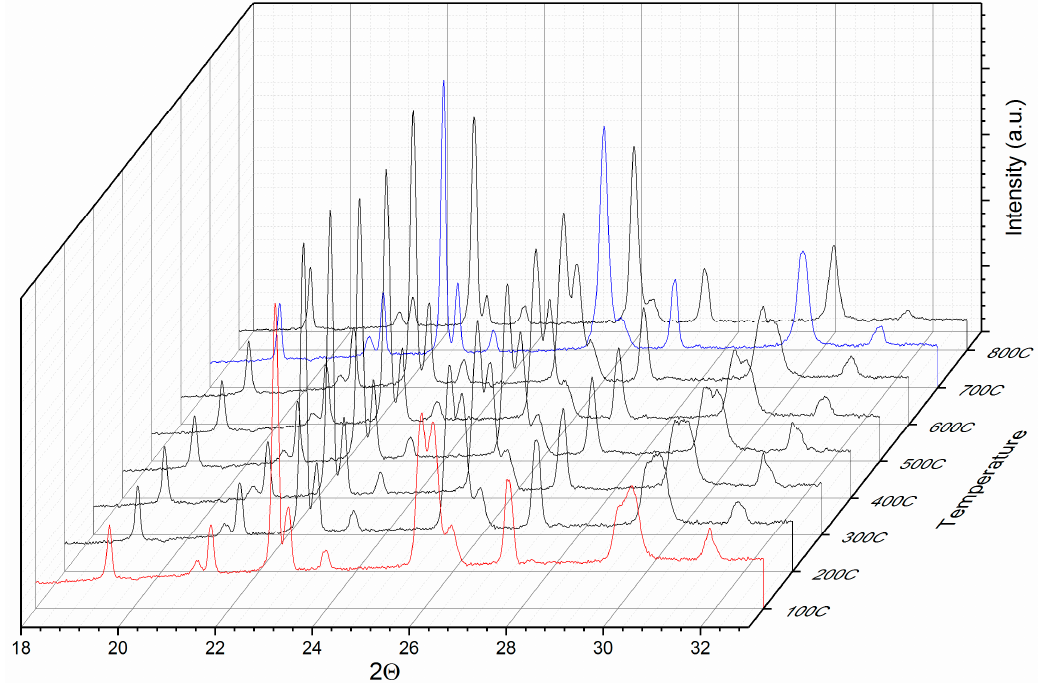
Figure 3. 3D representation of selected synchrotron XRD data taken between 100 and 800 °C for the as-cast sample.